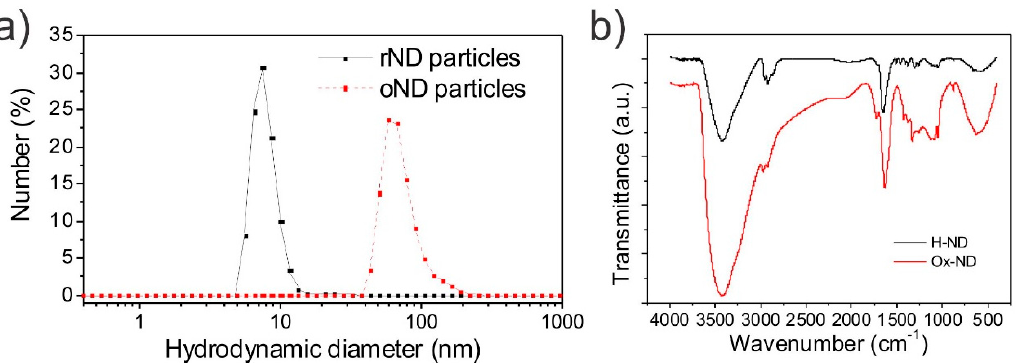
Figure 1. ( a ) Number weighted size (hydrodynamic diameter) distribution determined by DLS of hydrogenated (reduced) nanodiamond (rND) and oxidized ND (oND); ( b ) Fourier transform infrared spectra (FTIR) of as-received reduced and oxidized ND particles.